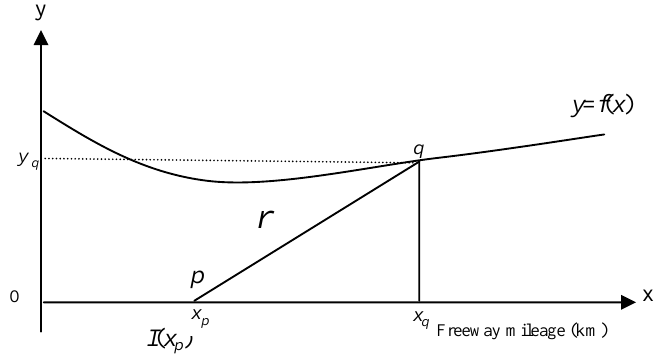
Figure 2. The attractive effect function of a freeway Figure 2 is only an illustration used to demonstrate the intuitive physical meaning of Formula 5. Usually, a freeway between two cities can be simplified as the abscissa axis, and the origin of the freeway can be seen as the origin of the abscissa axis. For a random spot q near the freeway, we can use coordinates ( x , y ) to denote its location relative to the origin. Therefore, q q the abscissa x of spot q is on the q